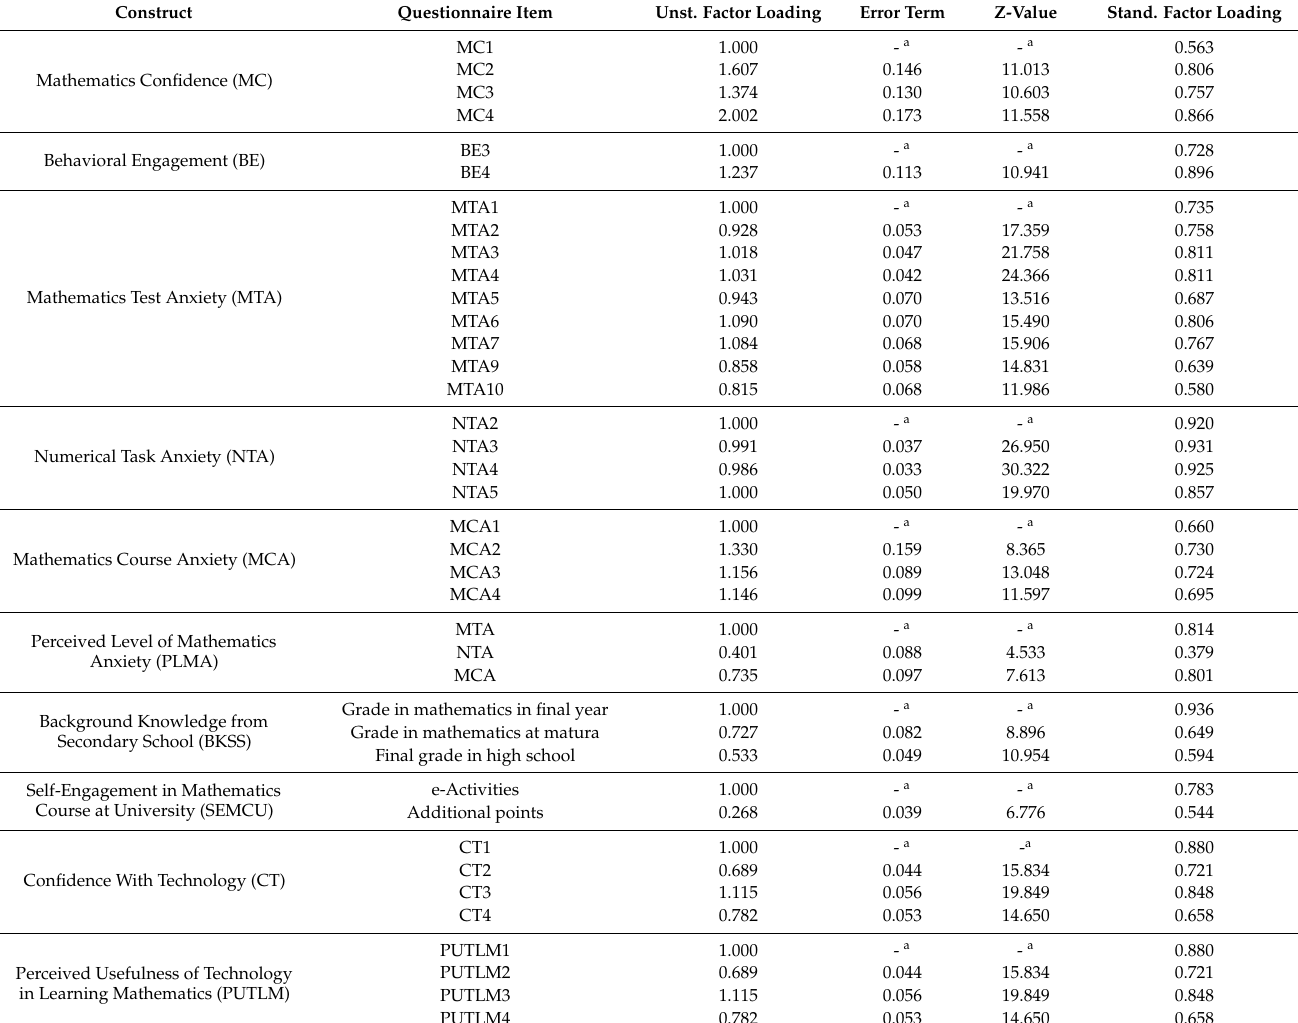
Table A1. Parameter estimates, error terms, and z-values for measurement